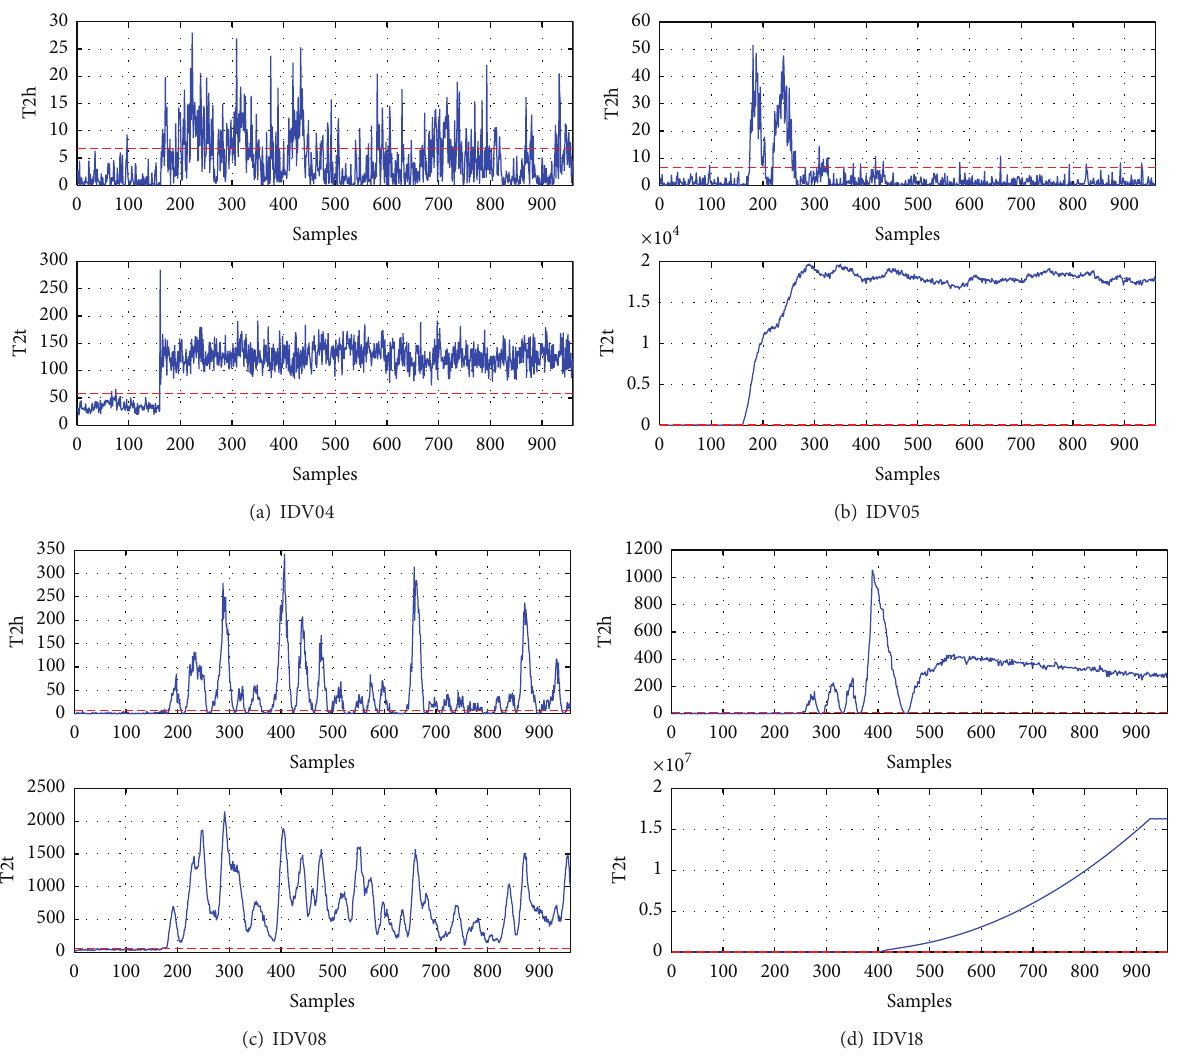
Figure 6: Fault detection using PRM-based monitoring